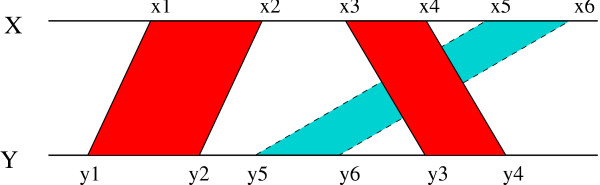
Identification of Breakpoints. From a list of high-scoring segment pairs (HSPs) obtained by use of BLASTN or TBLASTX and reduced to a non-overlapping subset by greedy-with-trimming [23], the number of breakpoints can be inferred as follows. In our example, the HSP (x5, x6, y5, y6) is located between the HSPs (x1, x2, y1, y2) and (x3, x4, y3, y4) in genome Y but not in genome X. This will be counted as a single breakpoint.